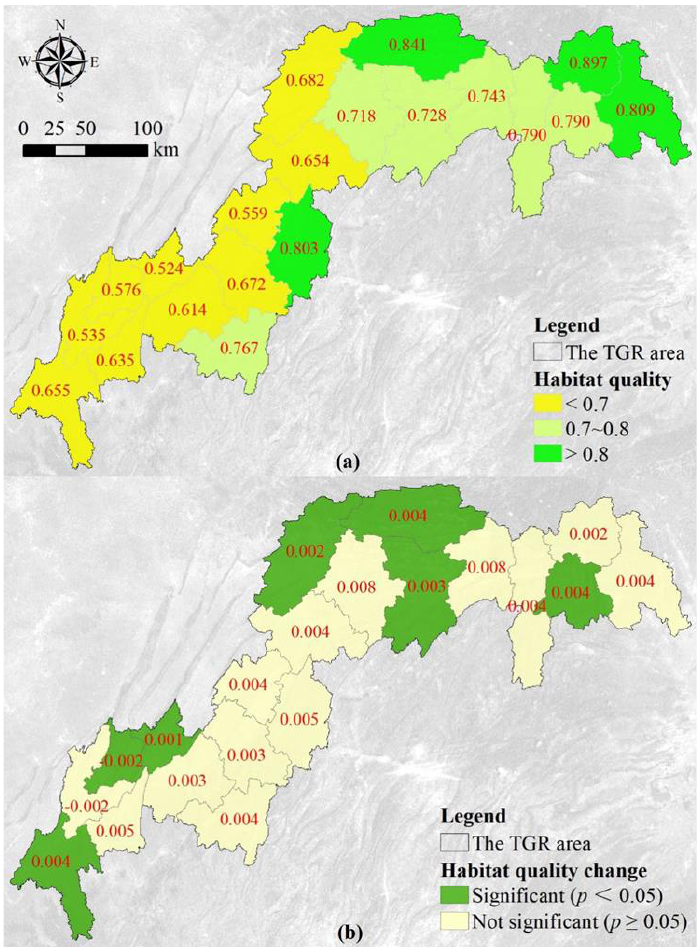
Figure 5. Average ( a ) and the modelled slope ( b ) of the habitat quality between 2000 and 2015 at county scale.